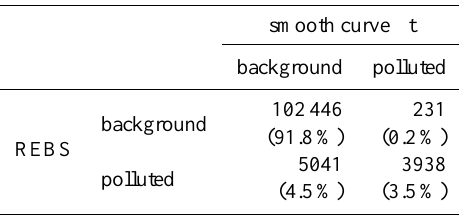
Table 1. Contingency table of the classification of the hourly CO values measured at Jungfraujoch from 1996 to 2009 ( n = 111656) derived from the REBS technique and the smooth curve fit.